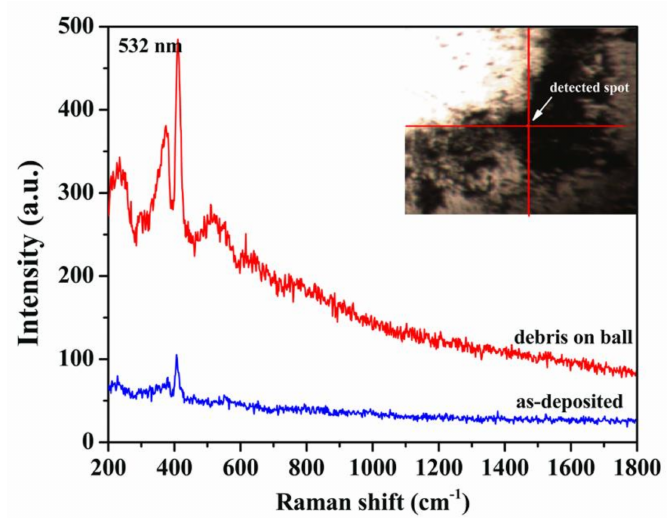
Figure 9. Raman spectra of wear debris derived from N6 films after sliding 1.8 × 10 5 revolutions in an ultrahigh